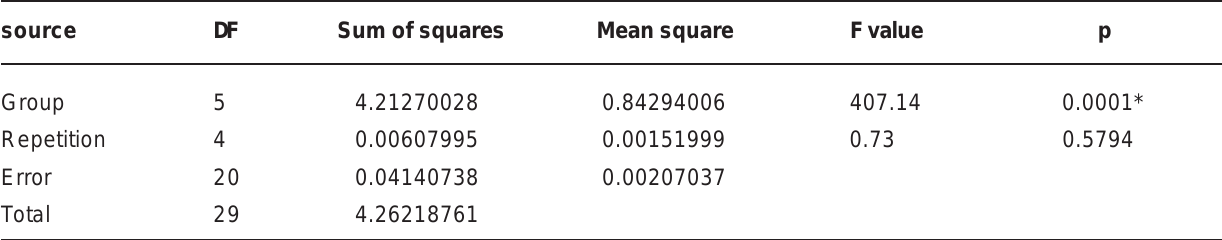
TABLE 2- ANOVA with data transformed in log